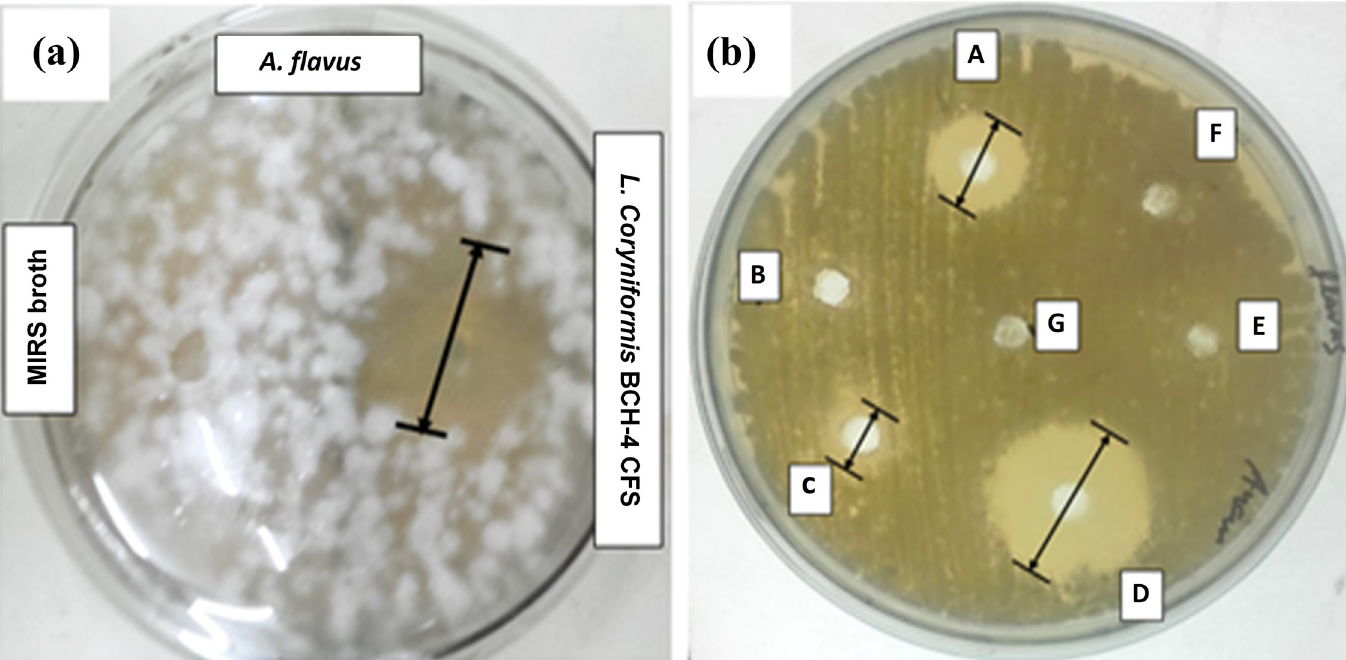
Fig 1. Zones of inhibition against aflatoxigenic A . flavus after 48 h of incubation at 30˚C. (a) Loig . coryniformis BCH-4 CFS. (b) Loig coryniformis BCH-4 CFS after different treatments [A] proteinase K [B] neutralization at pH 7 [C] pepsin [D] heat treatment (at 100˚C for 20 min) [E] catalase treatment [F] MRS broth [G] sterile distilled water.